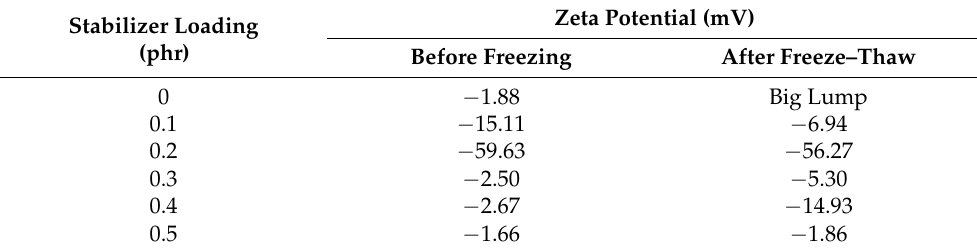
Table 2. Zeta potential values of AG-stabilized NRL particles before freezing and after the freeze– thaw process.